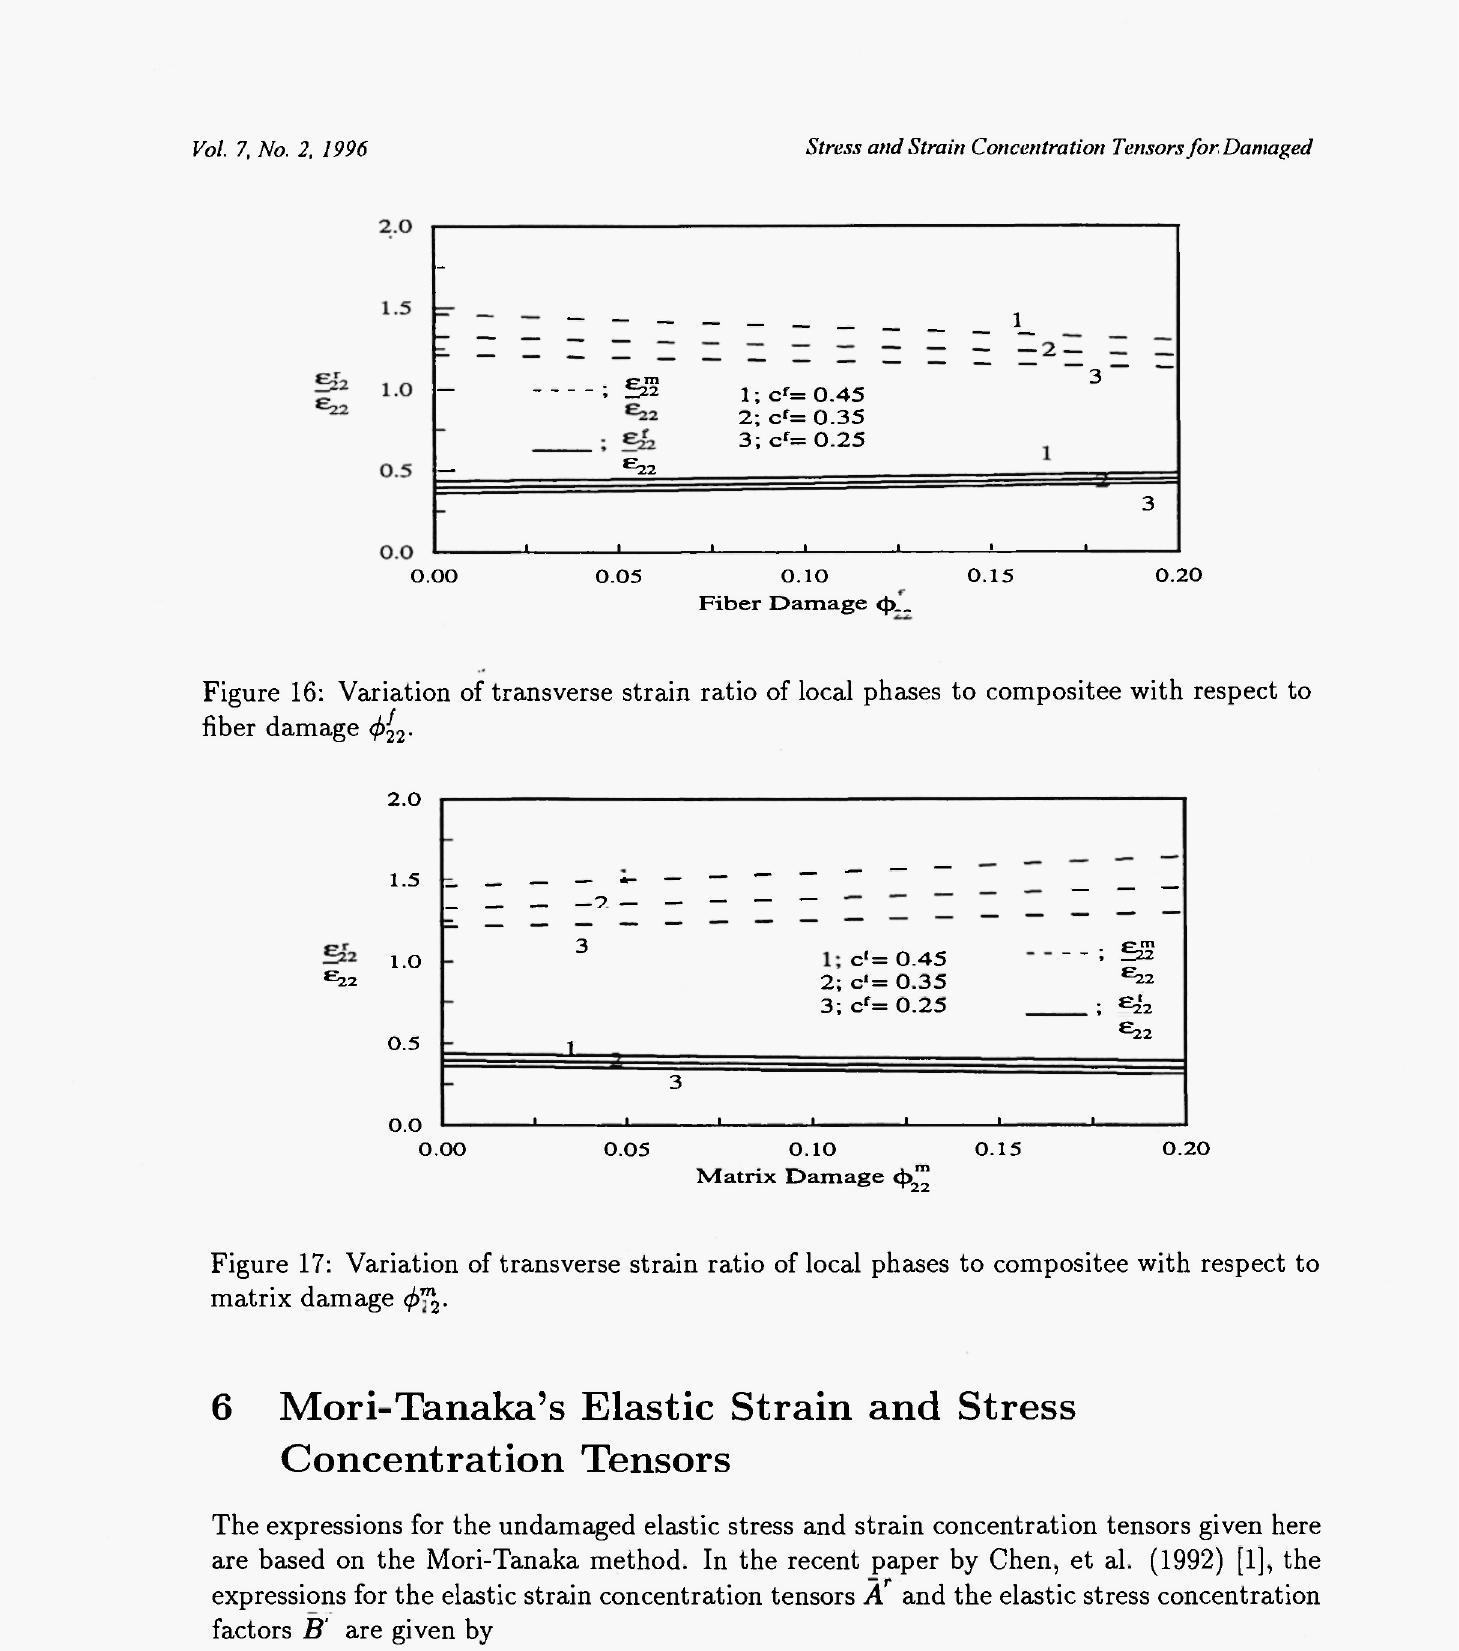
Figure 17: Variation of transverse strain ratio of local phases to compositee with respect to matrix damage φ™ 2